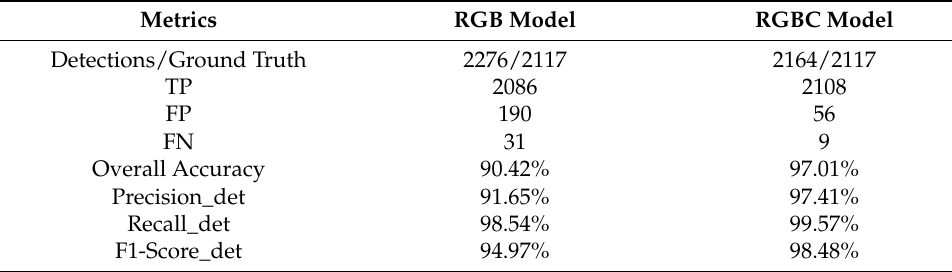
Table 3. Results of the crown detection